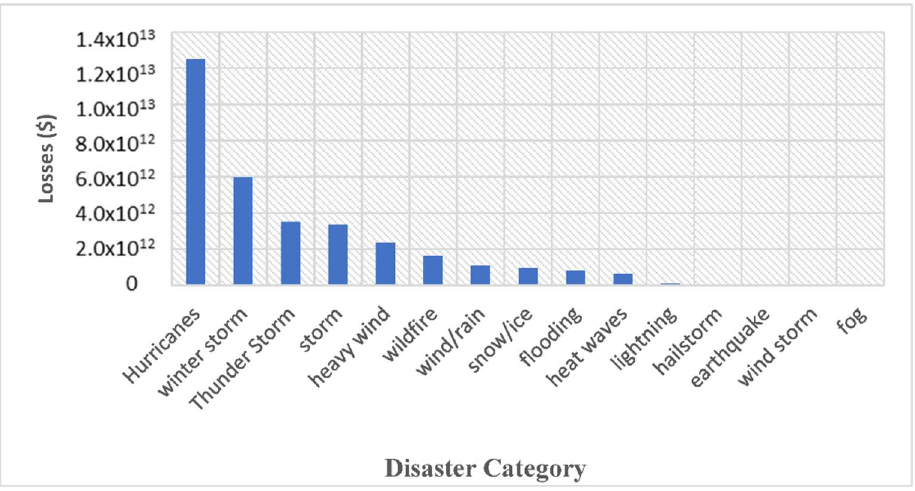
Figure 7. Total revenue loss (in USD) in top eight States of the U.S. against individual severe weather disaster categories.